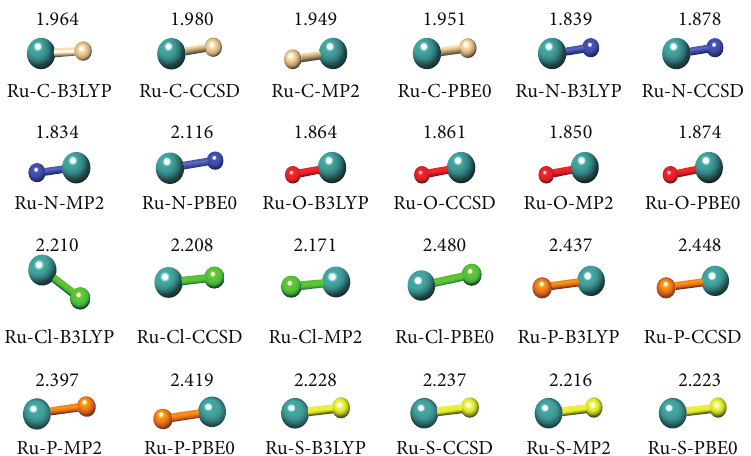
Figure 1: The bond distances of the six models of Ru-L bonds obtained from the optimized geometries at MP2, CCSD, PBE, and B3LYP using SBKJC VDZ basis set.